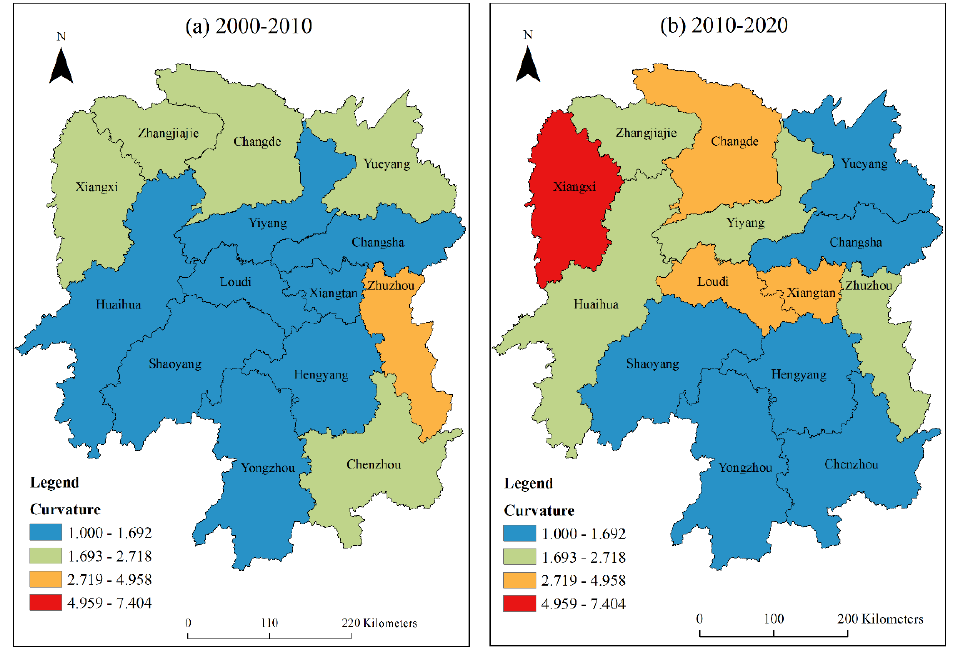
Figure 5. Spatial distribution of tortuosity of the LISA time path from 2000 to 2020.